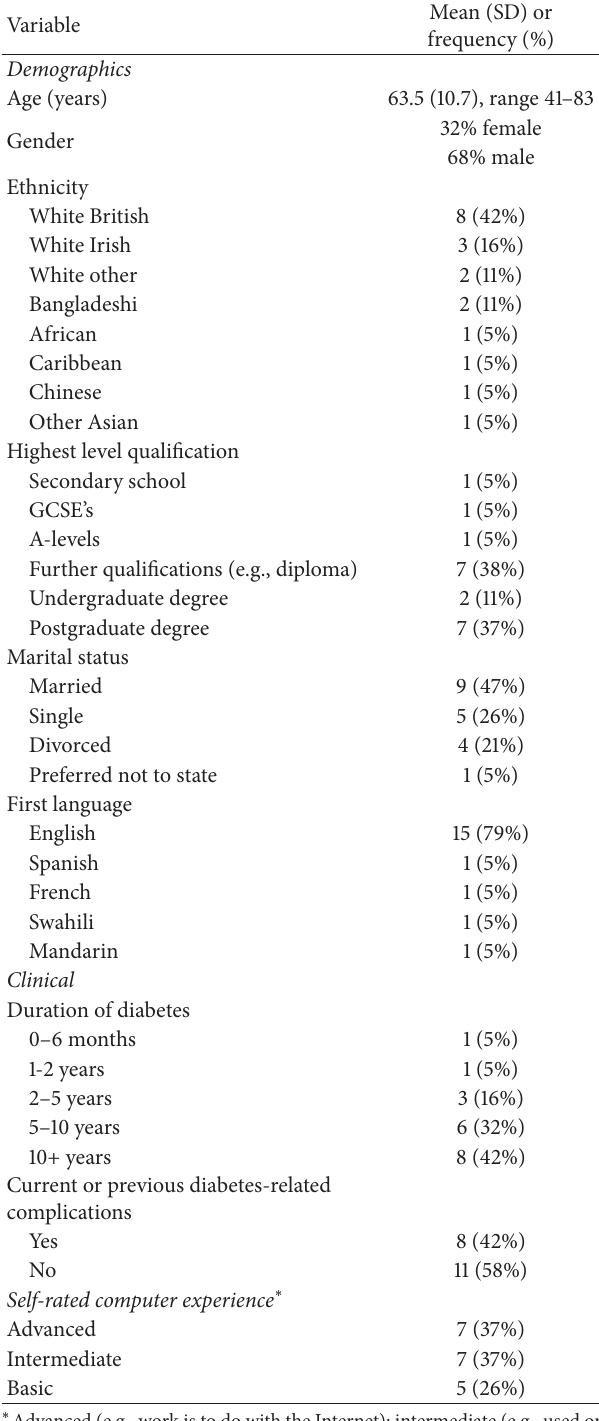
Table 1: Demographic and clinical characteristics of